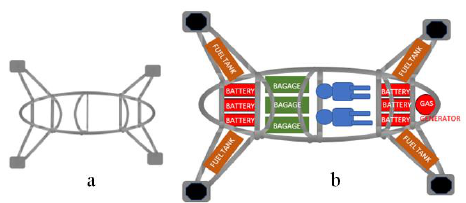
Figure 8. a. Basic model mainframe. b. Basic model fuel tanks battery and personnel allocation.